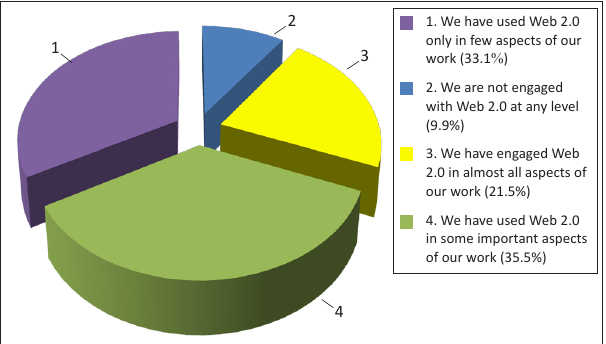
FIGURE 3: Number of visitors to civil society organisations social networking sites. FIGURE 4: Extent of usage of Web 2.0 by South African civil society